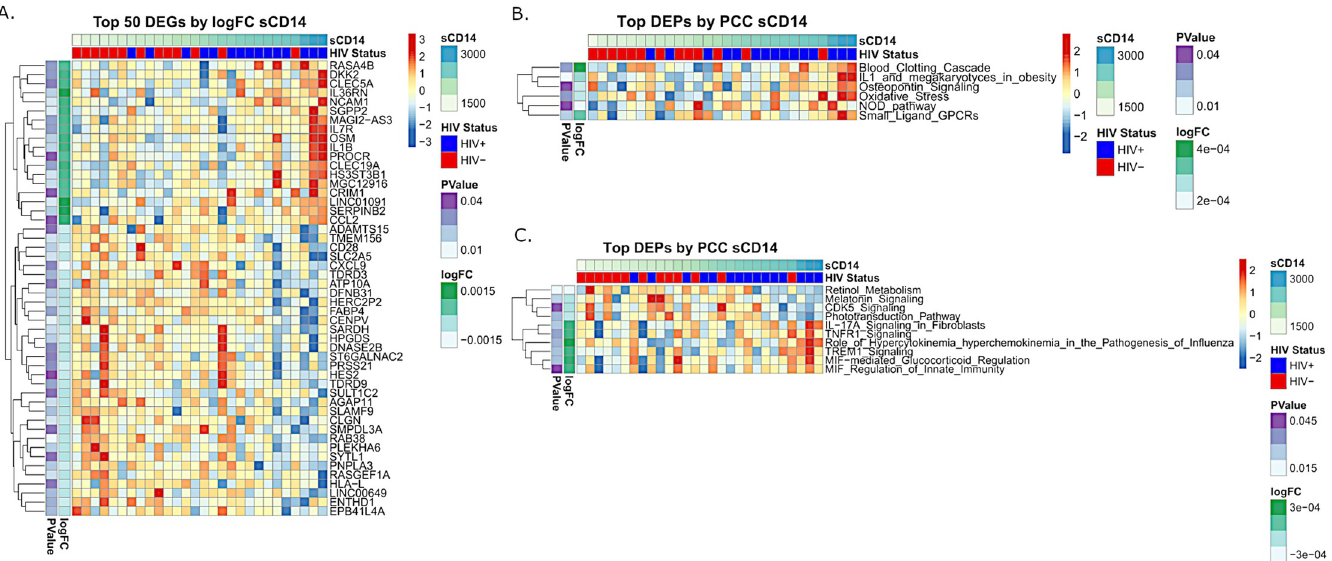
Fig 3. Biomarkers associated with morbidity and mortality in HIV infection correlate with unique DGE signatures and altered pathway activation. A) Top 50 differentially expressed genes regressed against donor sCD14 serum levels. B) Pathways identified using gene set variation analysis (GSVA) using the regressed genes selected above from donor sCD14 serum levels and ranked by P value (P � 0.05). C) Differentially expressed pathways (DEPs) were identified using GSVA and ranked by PCC (P � 0.05).